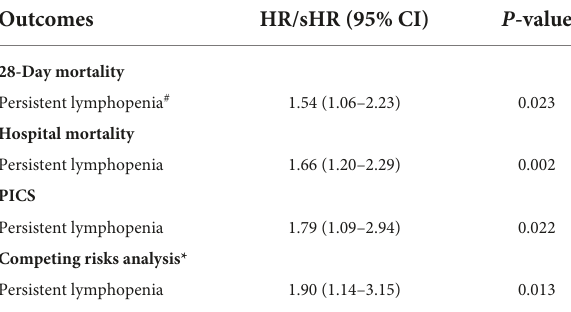
TABLE 2 Hazard ratios estimates for PICS and death from multivariate regression